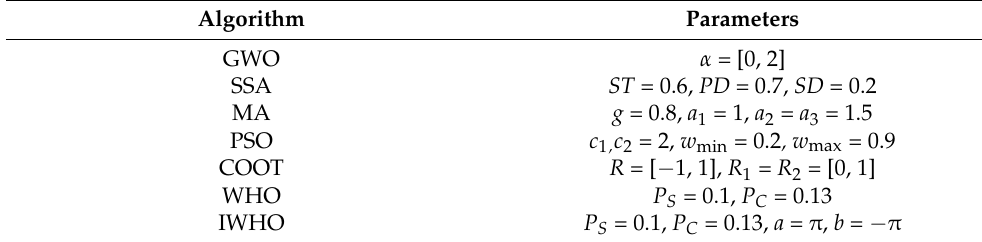
Table 1. Parameter settings of the algorithm.